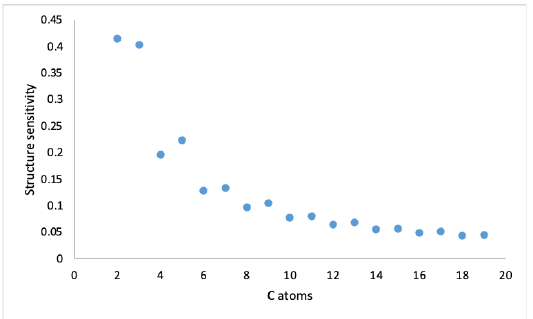
Figure 5. Distribution of structure sensitivity of graph